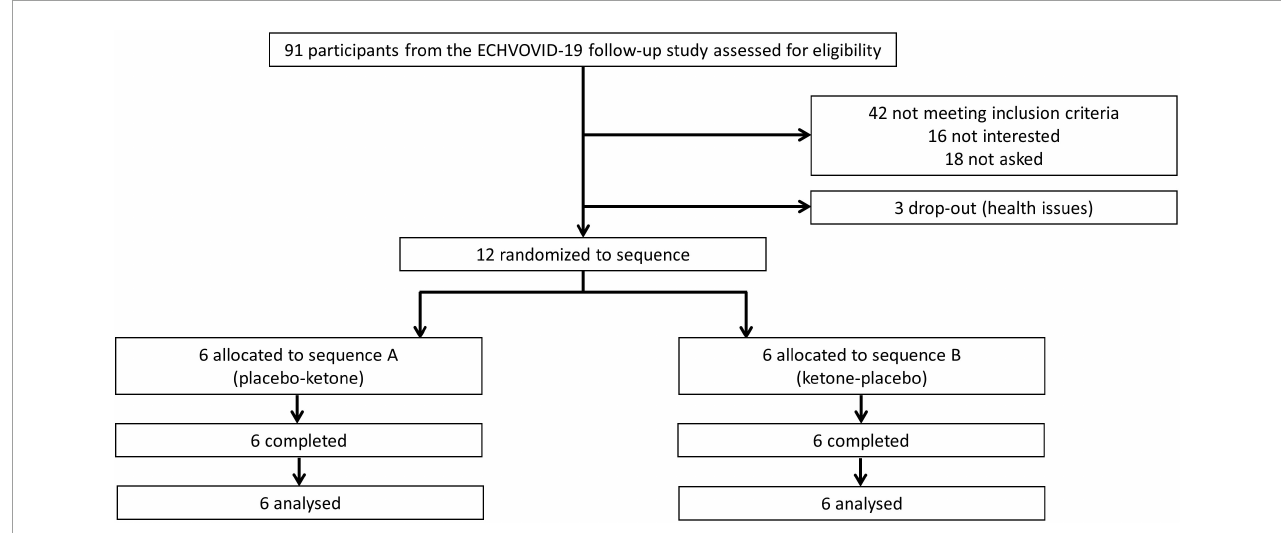
FIGURE1 Participant flow diagram. Three dropped out due to personal health issues (one broken foot, one had progression in cancer, one due to worsening of general health).